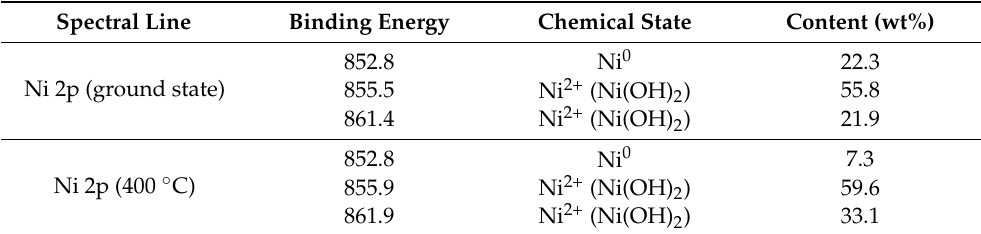
Table 3. Calibration results of Ni peaks in the alloy coatings at ground state and with heat treatment at 400 ◦